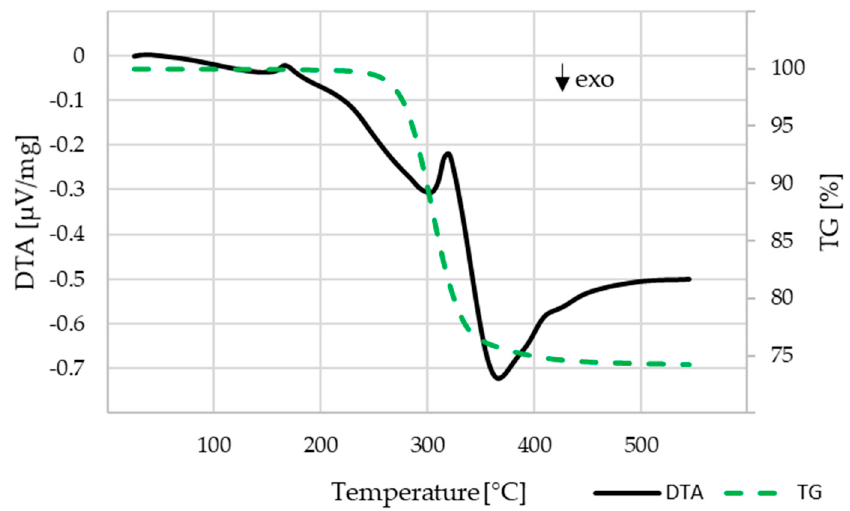
Figure 8. DTA-TG analysis for the C1 compound, heating rate 10 K/min, air atmosphere.